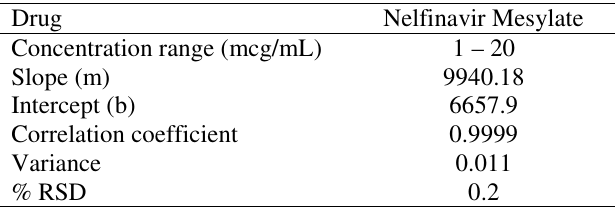
Table 1 . Linear Regression Data for Calibration curves.